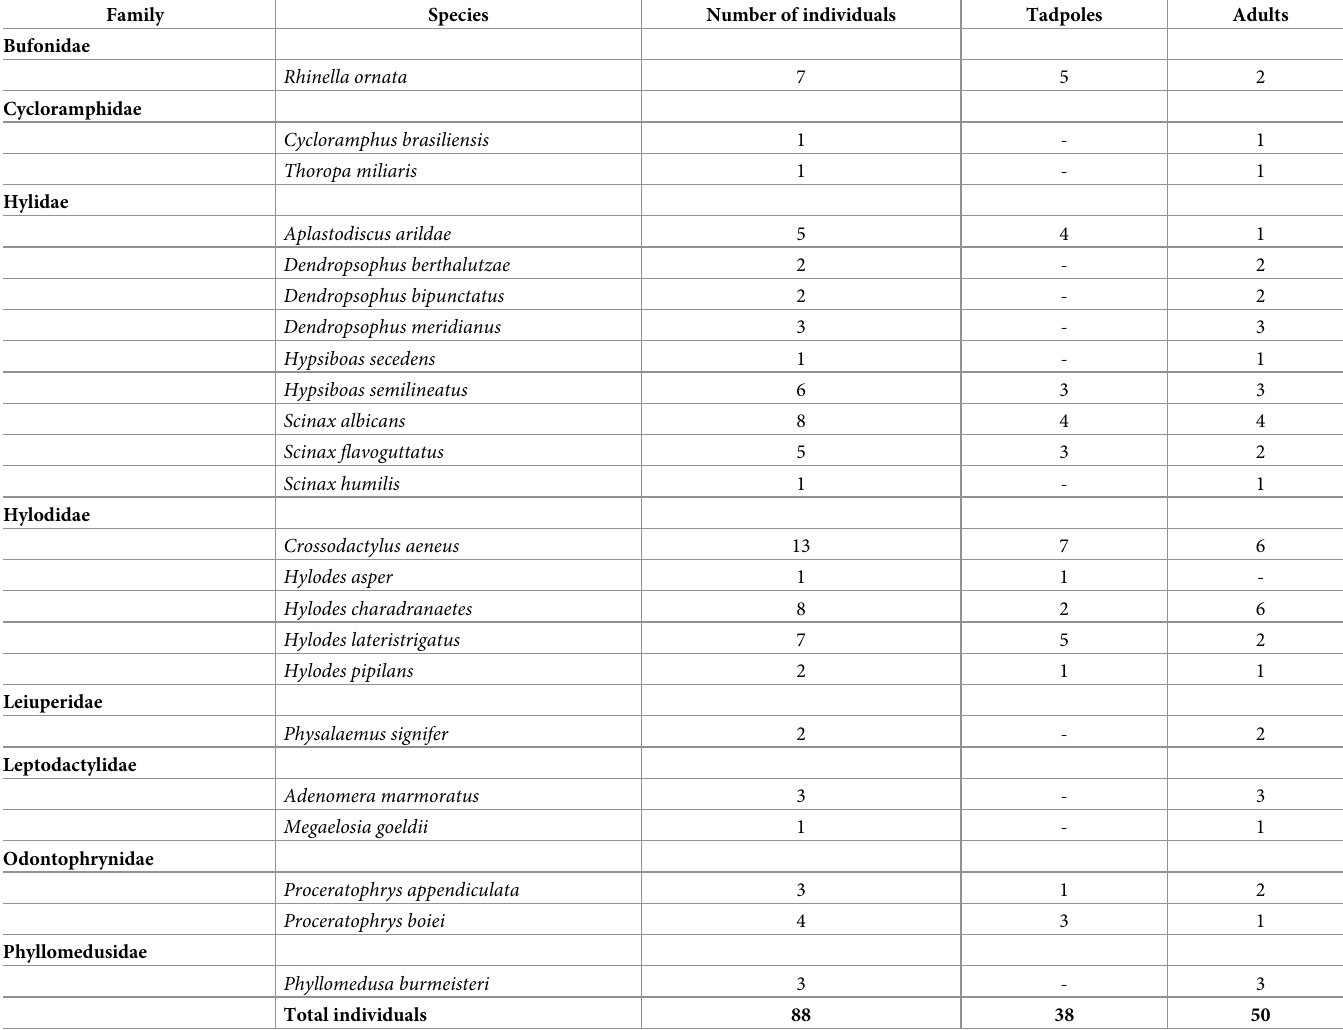
Table 1. List of collected species from REGUA area.